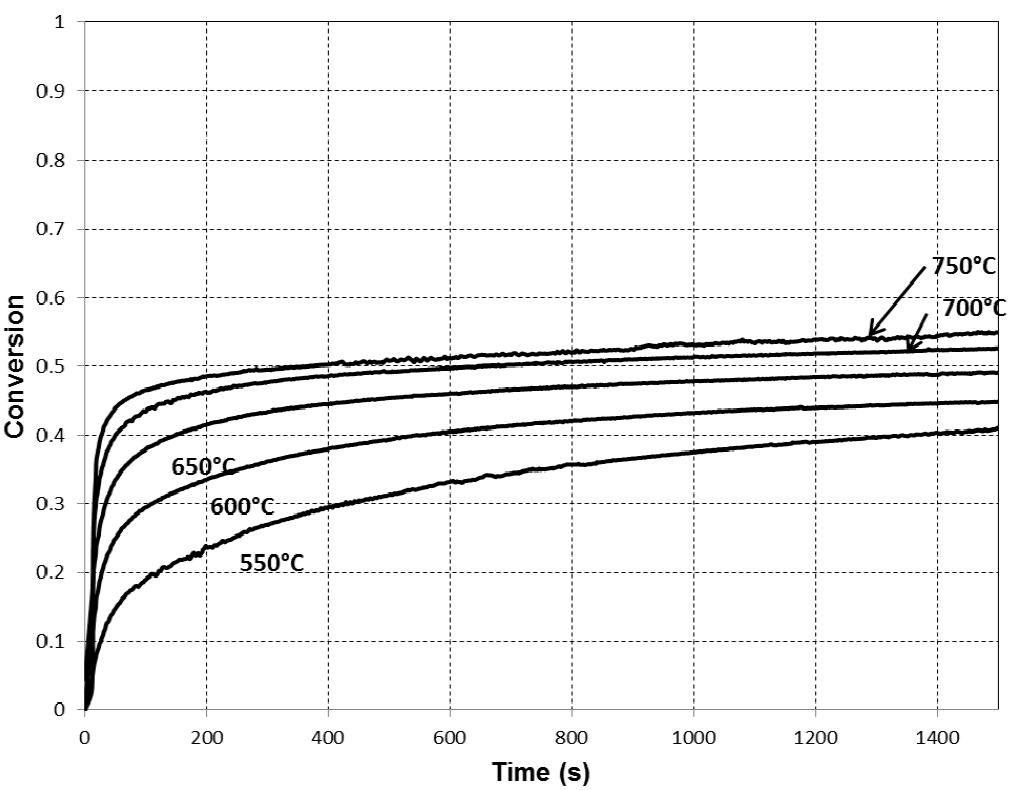
Figure 3. Carbonation behavior of the sample